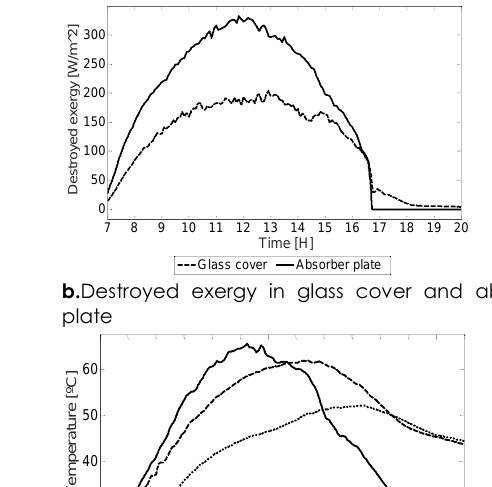
Figure 5. Results for December 16, 2016: a. Solar radiation, b. Destroyed exergy in glass cover and absorber plate,c. Destroyed exergy in PCM1 and PCM 2, d. Temperatures